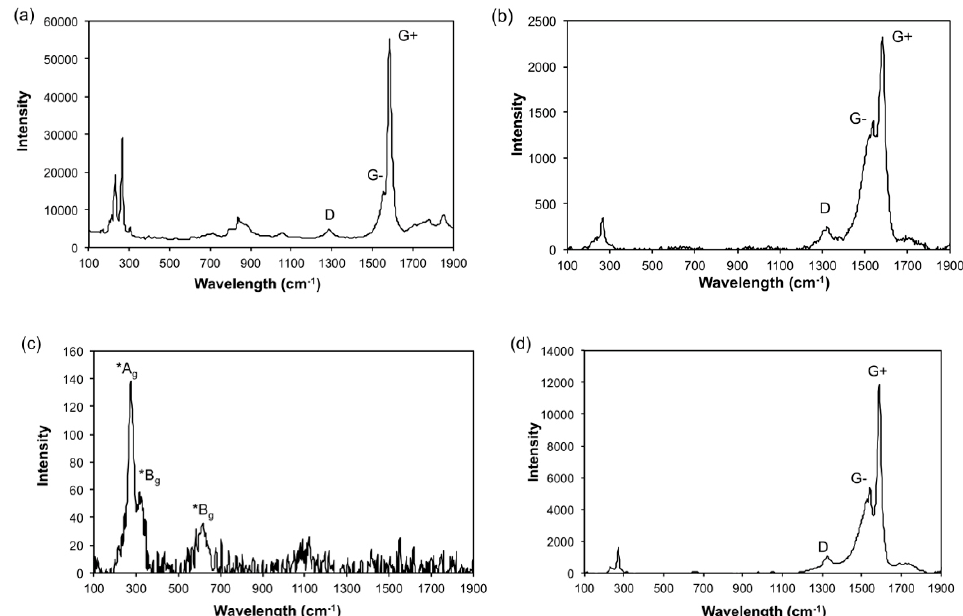
Figure 5. Raman spectra (514 nm) of ( a ) HiPCO SWCNTs before electrolysis, ( b ) Cu–SWCNT composite deposited with 6.2 wt% SWCNTs in CuSO 4 solution at a bath temperature of 60 ◦ C, ( c ) Cu deposited from CuSO 4 solution at a bath temperature of 60 ◦ C showing the peak for CuO, and ( d ) the hard adherent Cu–SWCNT coatings formed from electrolysis in the presence of Cu micropowder.